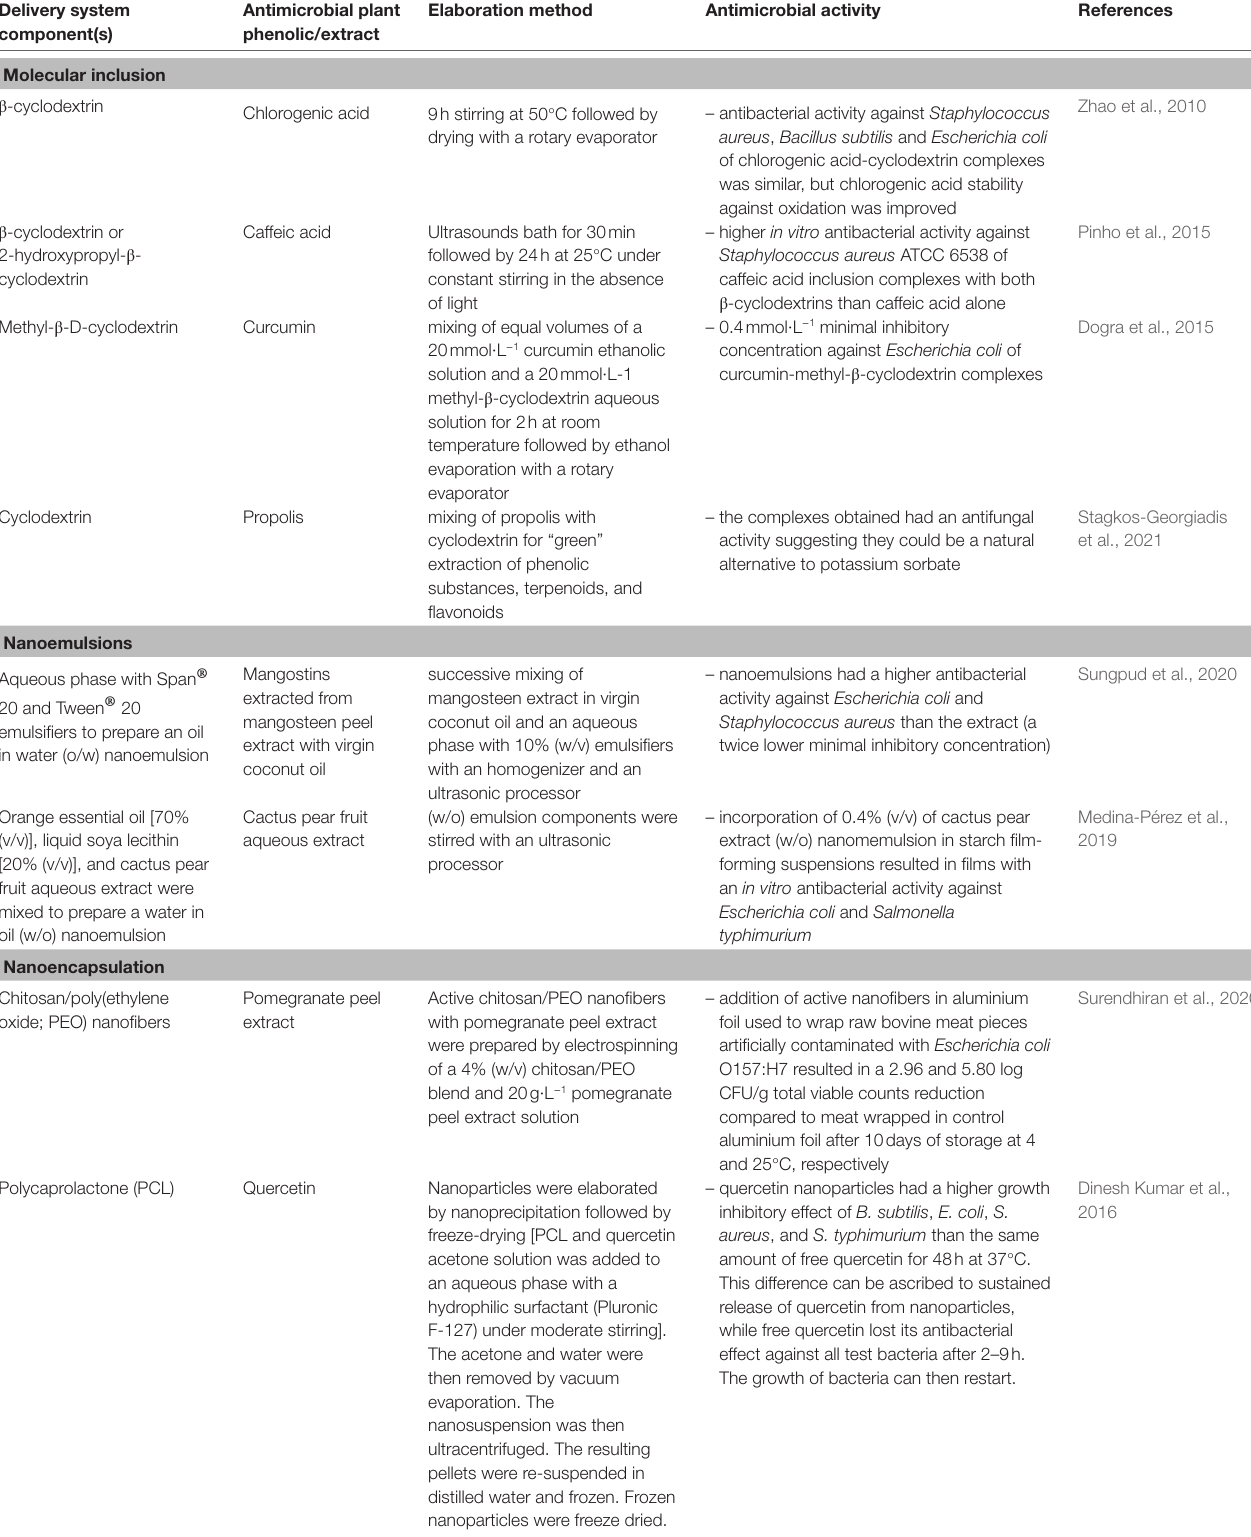
TABLE 5 | Examples illustrating the diversity of systems to deliver antimicrobial plant extracts/phenolics to extend the shelf life or improve the microbial safety of foods or to remove microbial